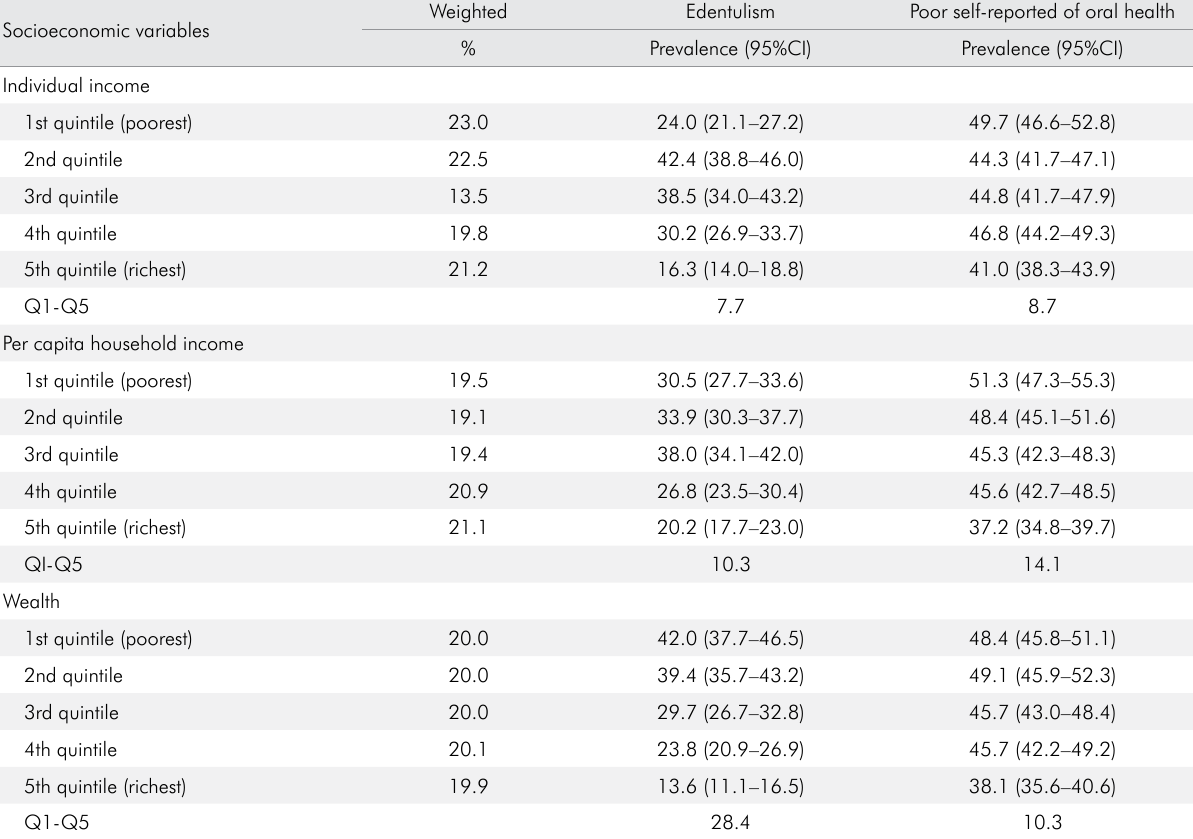
Table 2. Weighted Sample socioeconomic characteristics, prevalence and crude prevalence ratios of edentulism and poor self- perception of oral health among older adults at baseline of the Brazilian Longitudinal Study of